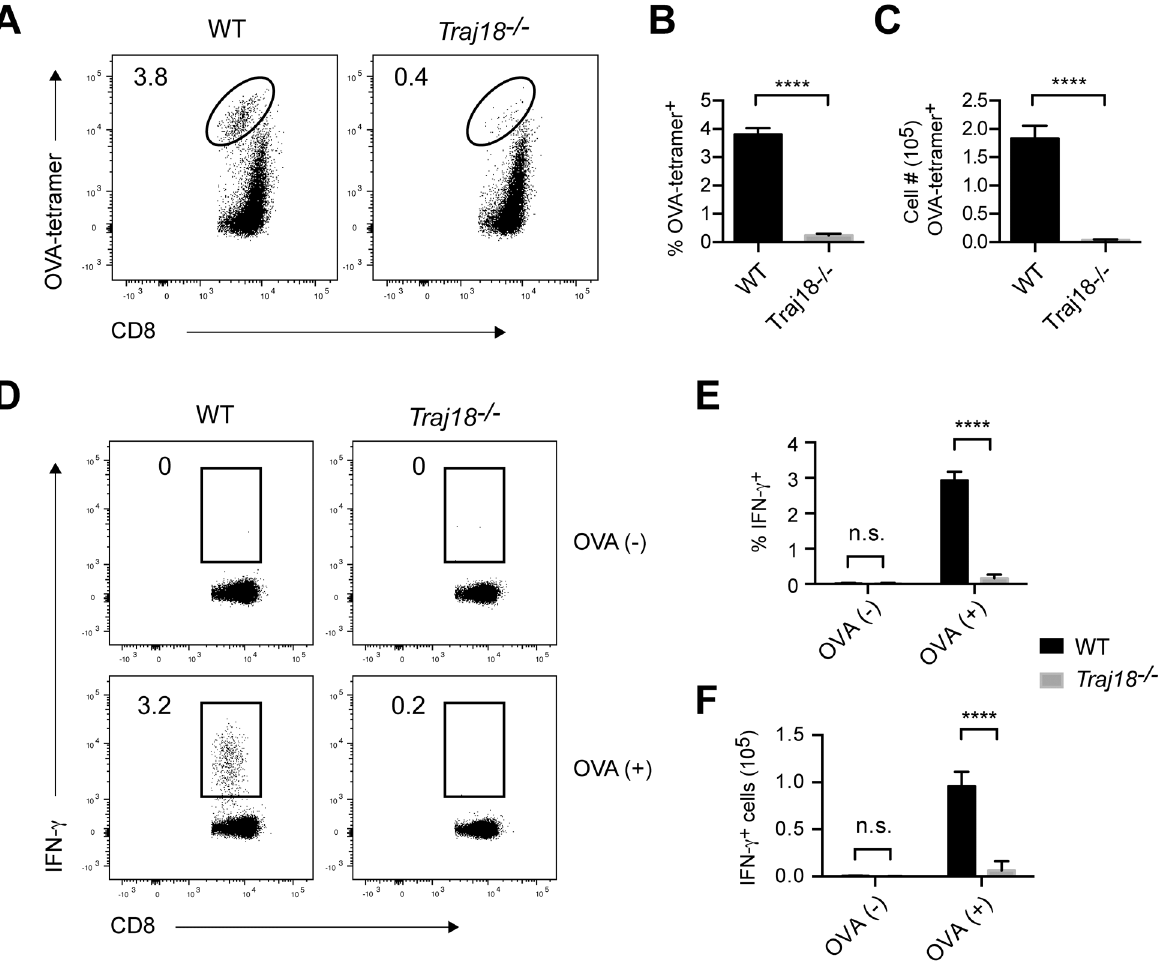
Fig 5. A validation of the adjuvant effect of V α 14 NKT cells using Traj18 -deficient mice. (A) NKT cell-mediated adjuvant effect on the expansion of antigen-specific CD8 T cells. WT and Traj18 -/- mice were immunized with OVA antigen and α GalCer on day 0, and splenocytes were analyzed on day 7. Numbers on FACS plots represent percentage of OVA-tetramer positive cells among viable CD8 T cells. (B) Cell percentages and (C) numbers of OVA- tetramer positive cells gated as shown in A. Bars depict mean ± SEM for n = 9 mice per group. (D) NKT cell-mediated adjuvant effect on the activation of antigen-specific CD8 T cells. WT and Traj18 -/- mice were immunized with OVA antigen and α GalCer on day 0, and splenocytes were harvested on day 7. Cells then were cultured in vitro with or without OVA 257-264 peptide for 6 h in the presence of GolgiPlug Protein Transport Inhibitor, and were stained with an IFN- γ mAb using Cytofix/Cytoperm kit. Numbers on FACS plots represent percentage of IFN- γ positive cells among CD8 T cells. (E) Percentages and (F) numbers of IFN- γ positive cells shown in D. Bars graphs depict mean ± SEM for n = 5 mice per group. All data shown are representative from three independent experiments. **** , P < 0.0001 using unpaired t